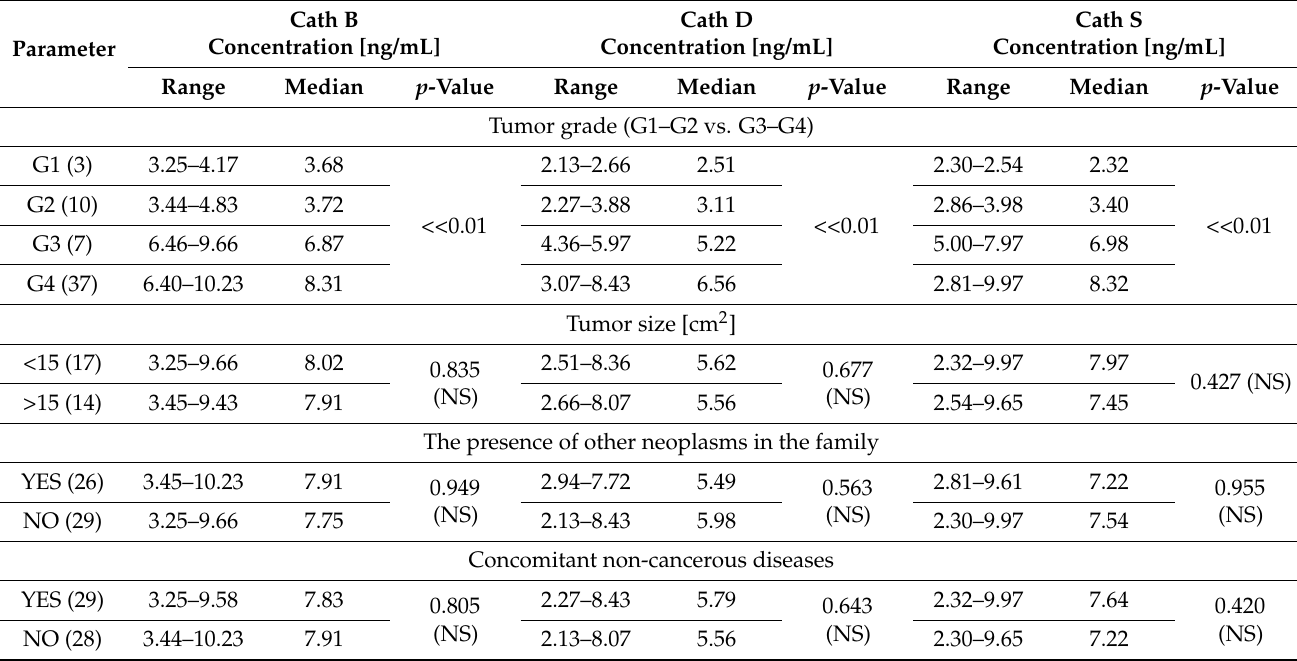
Table 2. Characterization of changes in cathepsin concentrations in relation to clinical